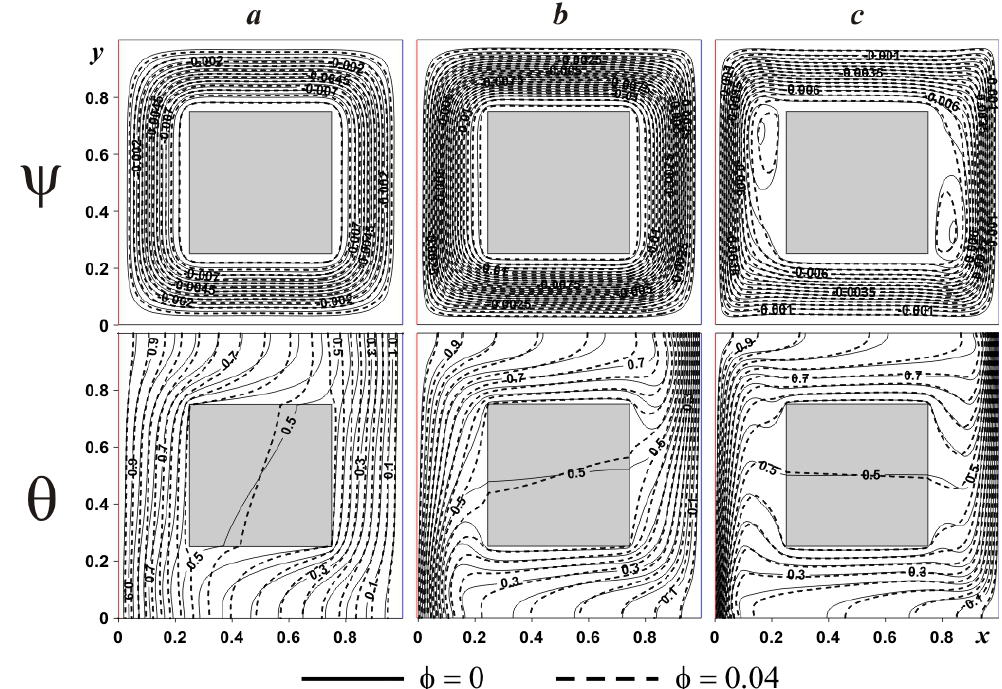
Figure 8. Isolines of ψ and θ for heat-conducting internal body at δ = 0.5 and different Ra and φ : ( a )— Ra = 10 4 , ( b )— Ra = 10 5 , ( c )— Ra = 10 6 .